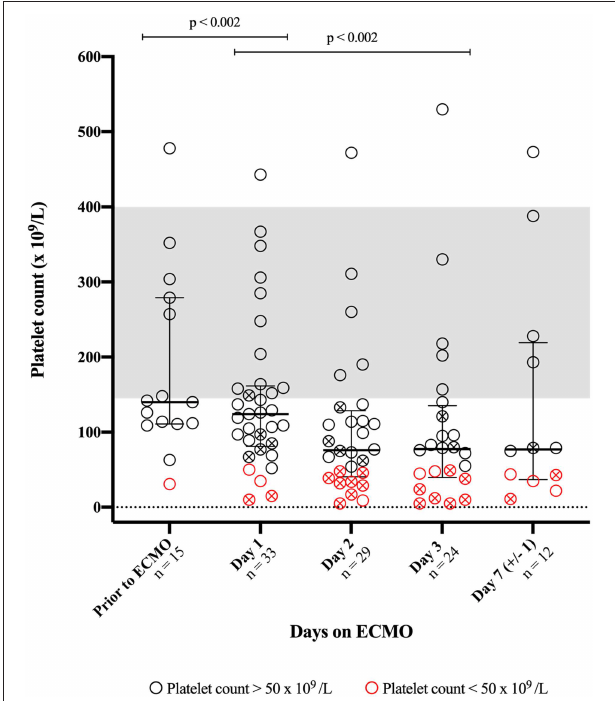
FIGURE 1 | Platelet counts obtained prior to and during support with extracorporeal membrane oxygenation (ECMO). The bars indicate median and interquartile range. The gray area represents a combined reference interval on platelet count for men and women. An X-mark in the circle indicates that the patient has received platelet concentrate within 24h prior to blood